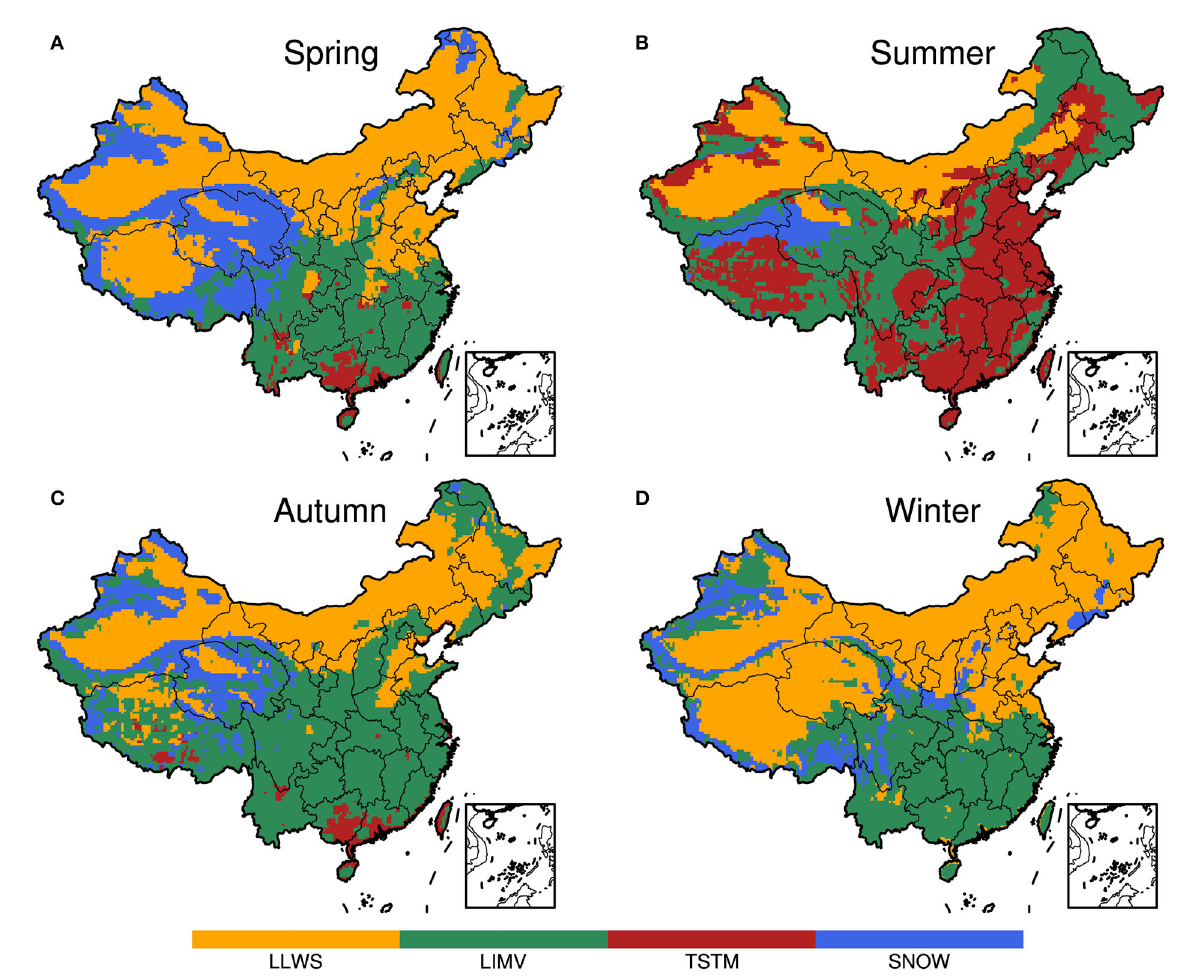
FIGURE6 Spatial distributions of the dominant types of hazardous weather in (A) spring, (B) summer, (C) autumn, and (D) winter namely, LLWS (orange), LIMV (green), TSTM (red), and SNOW